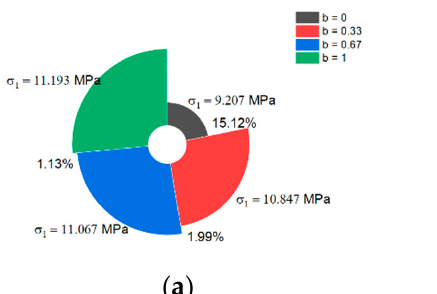
σ 1 intensity wind rose diagram, ( b ) σ 2 intensity wind rose diagram. intensity wind rose diagram, ( b ) σ 2 intensity wind rose diagram.